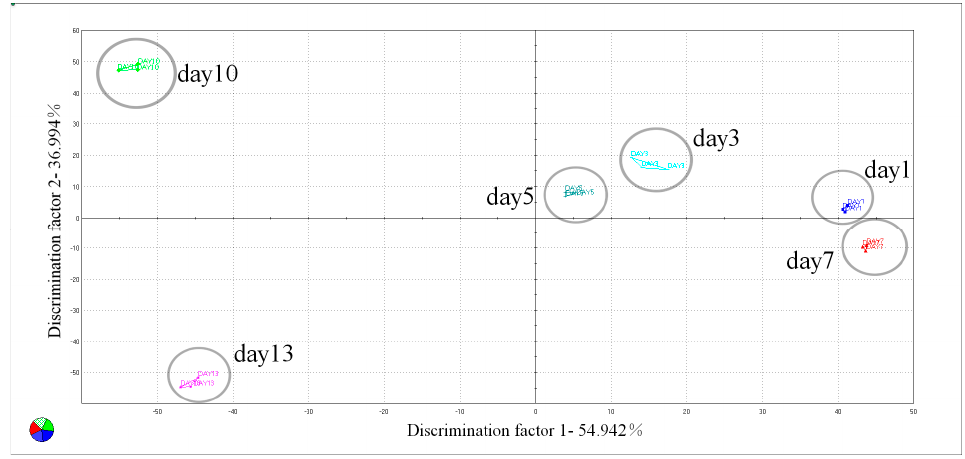
Figure 2. Results of e − nose of DFA plot of the stinky tofu samples in di ff erent storage periods.